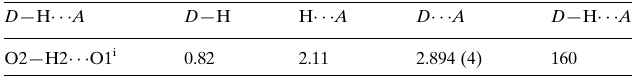
Hydrogen-bond geometry (A˚ , (cid:5)